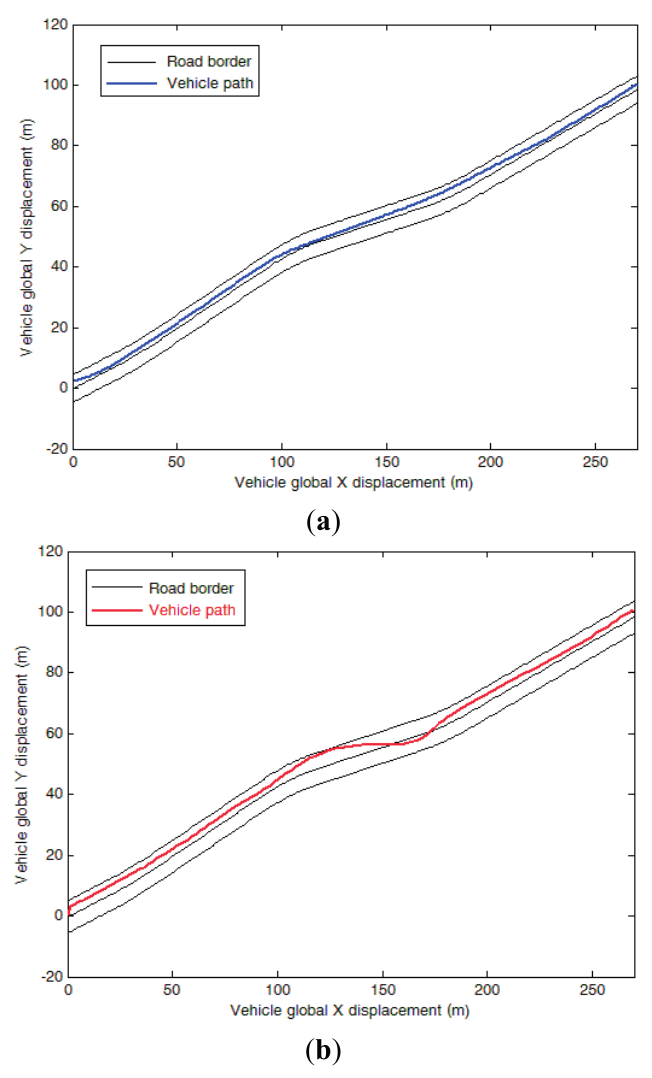
Figure 4. Vehicle path sample for a 20 s period and speed of 60 km/h. ( a ) Alert and ( b ) drowsy driver.